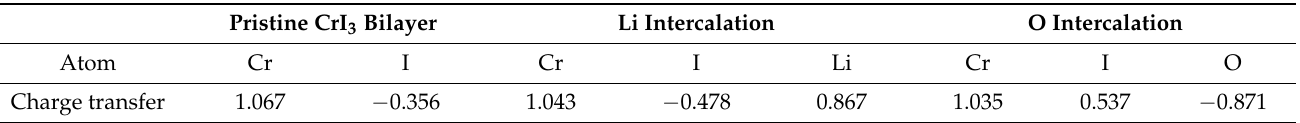
Table 1. Charge transfer based on the Bader charge calculation in the pristine high-temperature (HT) phase of the CrI 3 bilayer, Li intercalated, and O intercalated HT phase in 2 × 2 supercell, respectively. A negative value indicates charge accumulation on the respective atom, while a positive value indicates charge